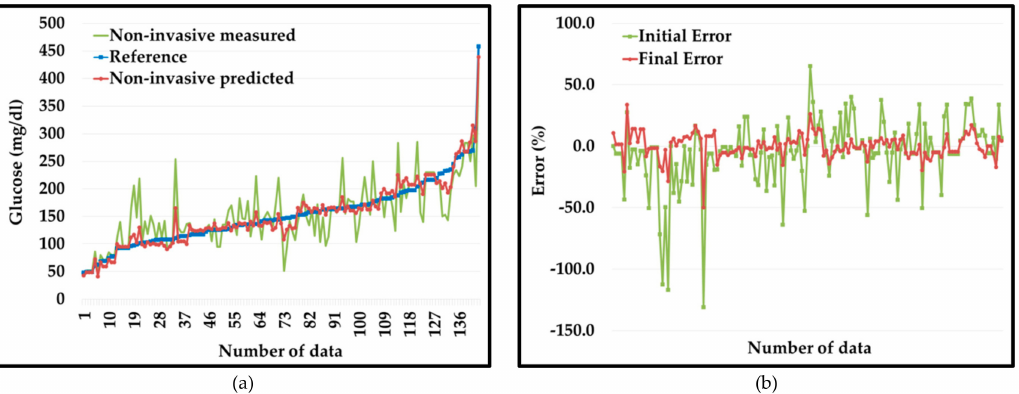
Figure 6. ( a ) Non-invasive measured (in green color) vs. non-invasive predicted (in red color) with respect to reference values (in blue color). ( b ) Percentage error non-invasive measured (in green color) vs. non-invasive predicted (in red color) for dataset 2.